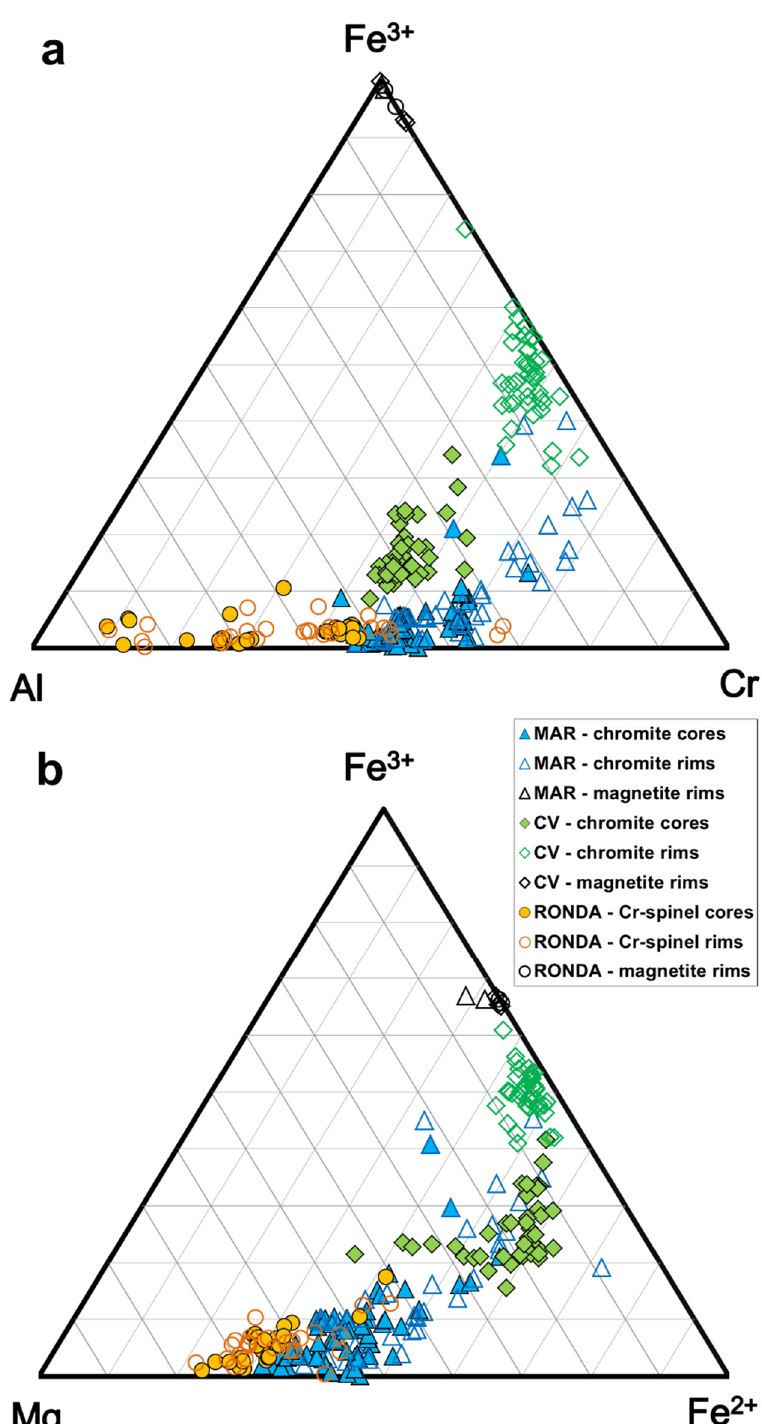
Figure 4. Ternary plots ( a ) Al-Cr-Fe 3+ and ( b ) Mg-Fe 2+ -Fe 3+ for the cores and rims of the MAR magnesiochromites, CV chromites, and Ronda chromian spinels. EMP data for MAR chromites (Tables A1 and S1; Figure 3) confirm petrographic ob- servations: most non-opaque chromite cores are magnesiochromites, with Mg# = 0.68–0.29 and Cr# = 0.44–0.76, whereas corresponding chromite rims stray towards Fe- and Cr-richer compositions (Mg# = 0.63–0.10 and Cr# = 0.46–0.95). Opaque chromite grains, found